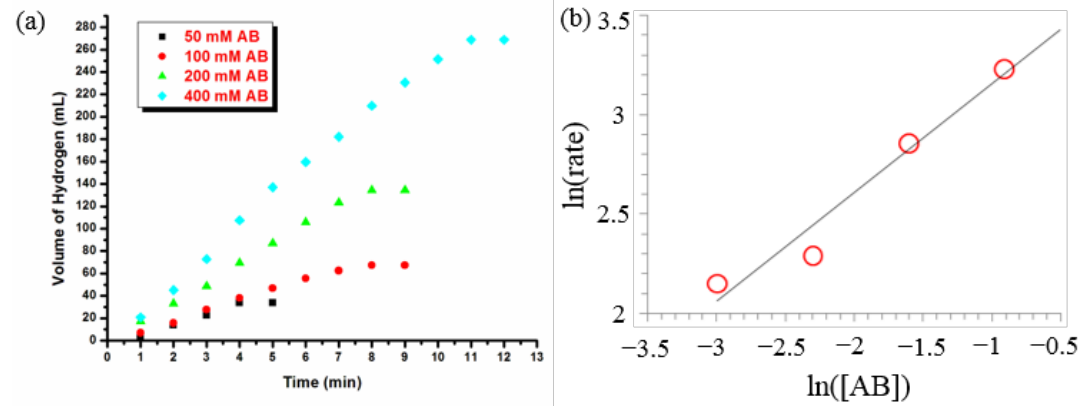
Figure 1. ( a ) The volume of hydrogen versus time graph for the ruthenium(0) NP-catalyzed hydrolysis of AB (100 mM) started with different ruthenium concentrations at 25.0 ± 0.1 °C; ( b ) plot of initial TOF values versus catalyst concentration; ( c ) plot of hydrogen generation rate versus the catalyst concentration, both in logarithmic scale.